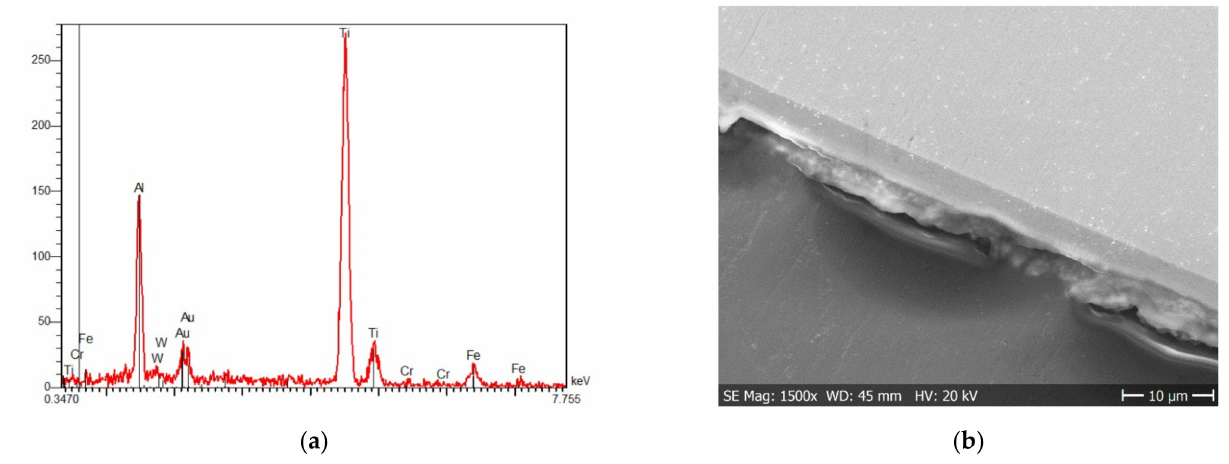
Figure 5. SEM results of the N-H-PVD test sample: ( a ) chemical composition and ( b ) SEM image.